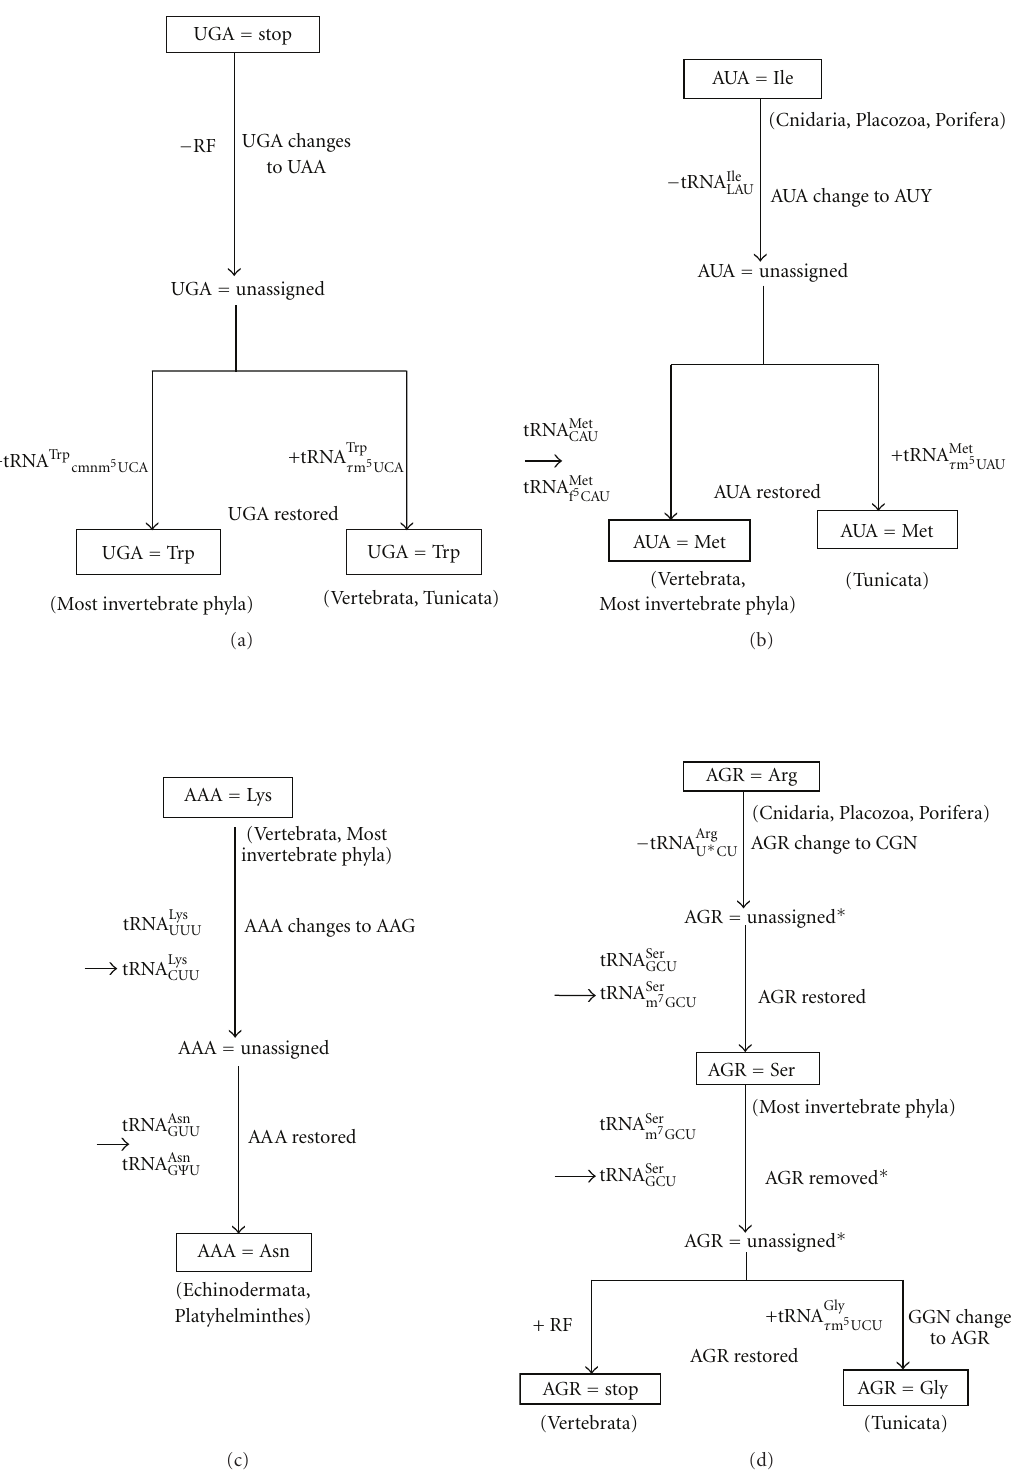
Figure 4: Schematic drawings showing the possible evolutionary changes of UGA (a), AUA (b), AAA (c), and AGR (d) codons in animal mitochondrial genomes. ∗ In order to exclude too complicated situations, simple formulas were adopted for the process of the possible evolutionary changes of AGR codons in this figure. For details, see